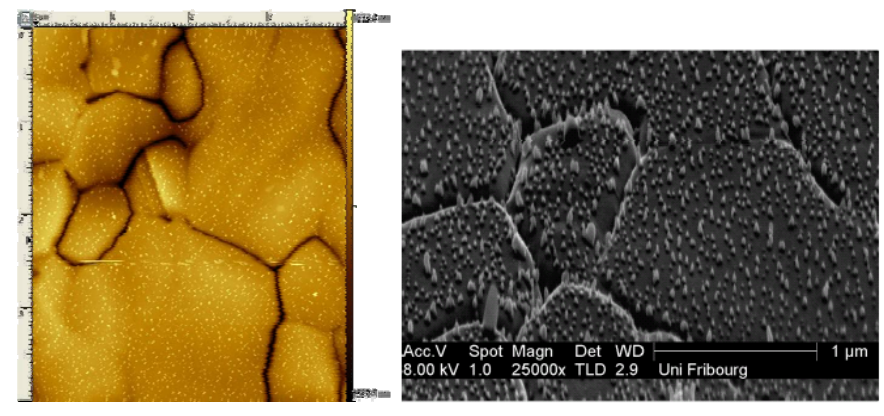
Figure 4. AFM (left) and scanning electron microscopy (SEM; right) pictures of the deposit of compound 2 on Au(111)